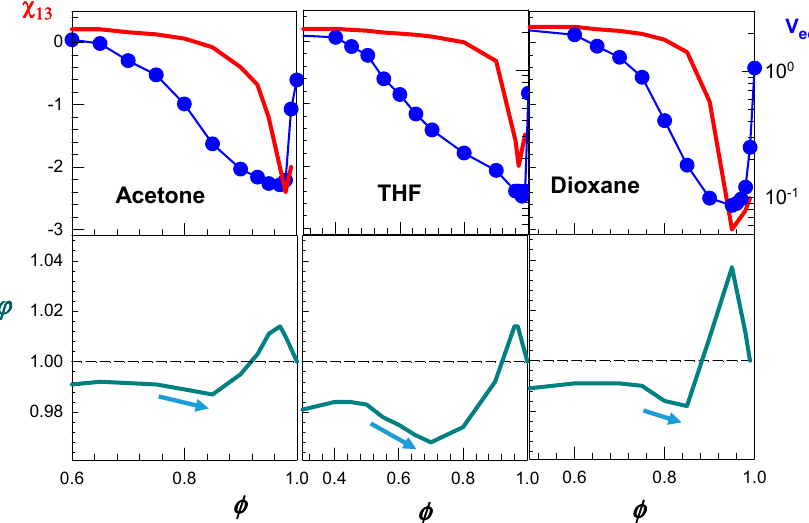
Figure 10. Interaction parameter χ 13 (red curves), hydrogel volume V eq (blue symbols), and the partition parameter ϕ (bottom curves) plotted against the cosolvent volume fraction φ in the water– cosolvent mixture. Calculations were using the Equations (6)–(8). The cosolvents are indicated. The horizontal dotted lines represent the condition ϕ = 1. Adapted from [49] with permission from the Elsevier